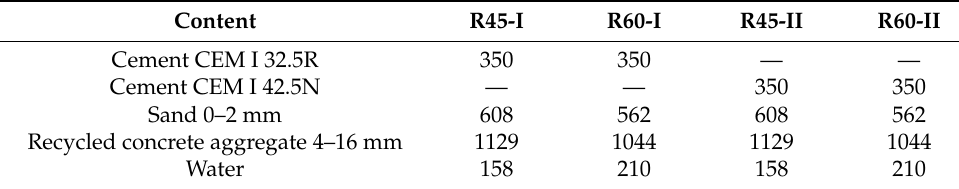
Table 1. Recipes of tested groups of concrete mixtures. Content